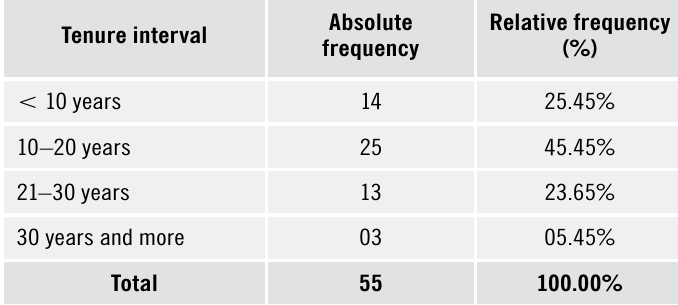
Tenure interval